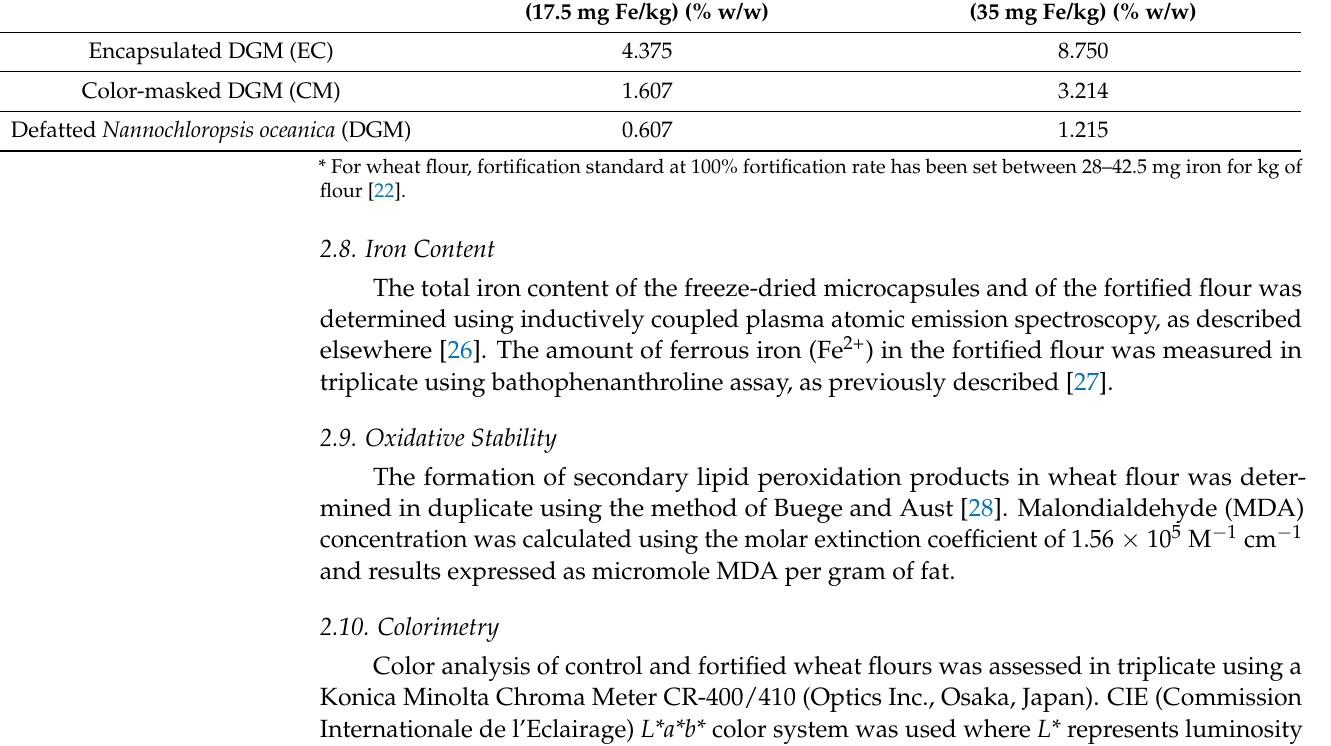
Table 1. Amount of non-encapsulated (DGM), encapsulated (EC) and color-masked (CM) defatted Nannochloropsis oceanica added to wheat flour (WF, control) for shelf-life and sensory study *. Fortified 50% of